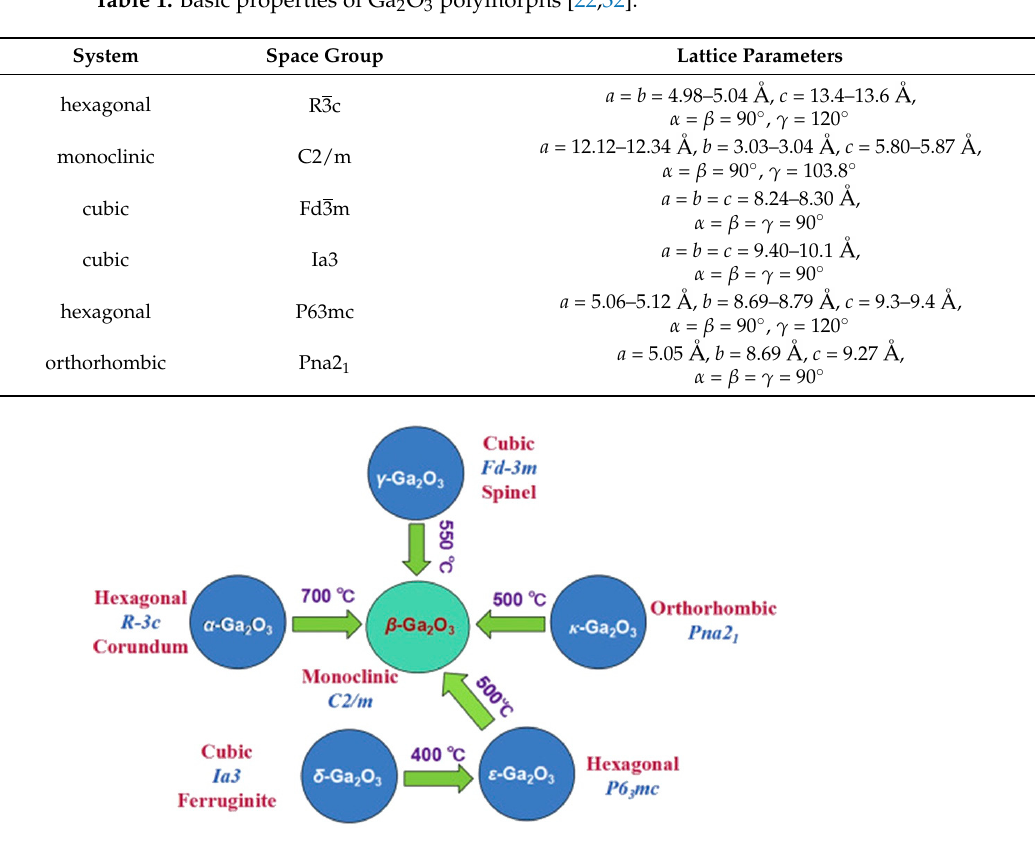
Figure 2. Interconversion relation of Ga 2 O 3 polymorphs [22]. Copyright 2019 Elsevier.